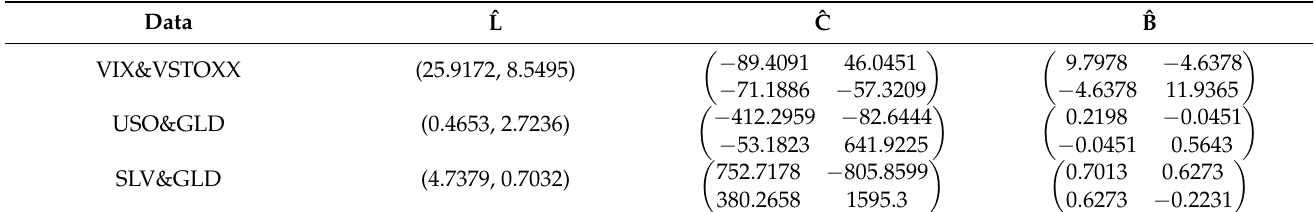
Table 8. Estimated original drift group parameters.